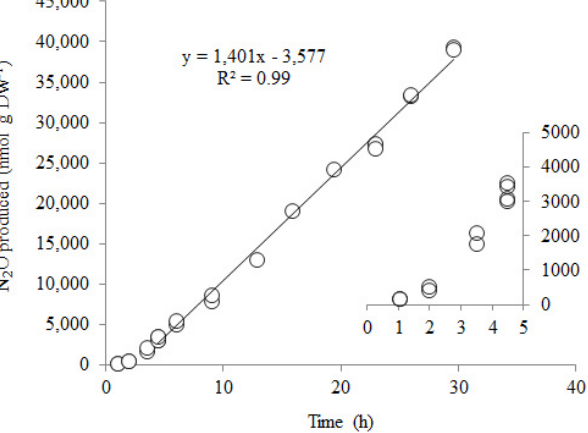
Fig. 5. Time change of N 2 O production (nmolg DW − 1 ) in C. vul- garis supplied with 12mM nitrite as sole exogenous nitrogen source and incubated in the dark. The plain line represents the linear re- gressing over 4.5–29.5h. Insert shows initial build-up phase. The data shown is a combined plot of duplicates (e.g. not the average) from 3 independent